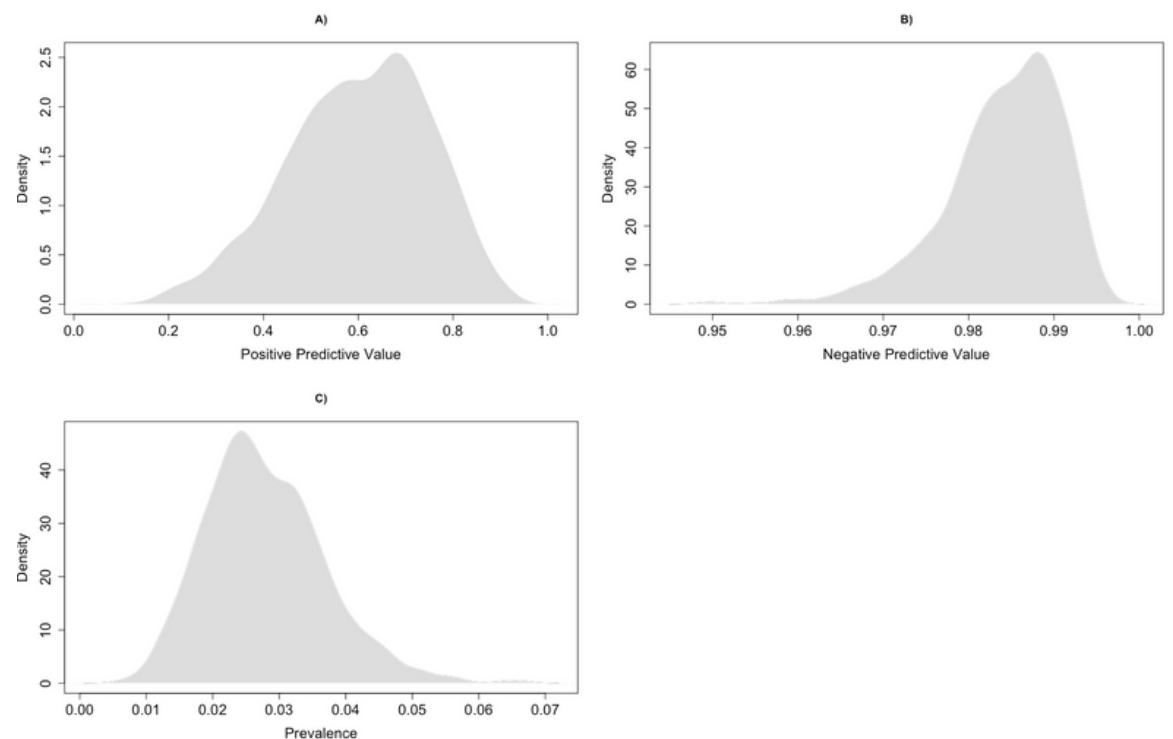
Figure 3. Density plots depicting the distribution of simulated positive predictive value (A), negative predictive value (B), and true prevalence (C) obtained during the quantitative bias analysis of outcome